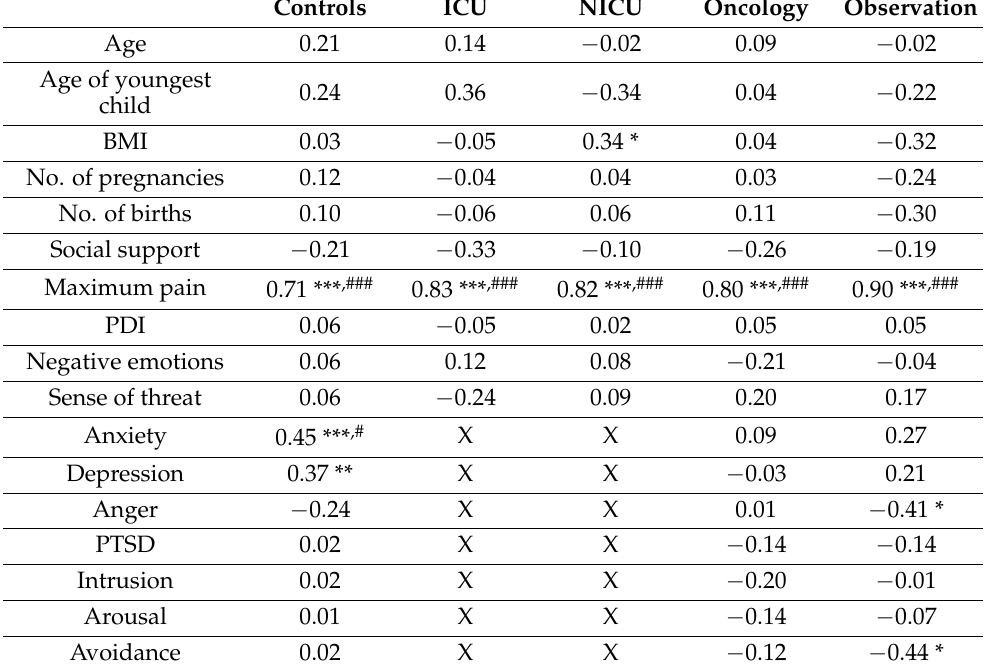
Table 7. Correlations between the intensity of average pain and selected demographic, medical, and psychological variables (Spearman’s